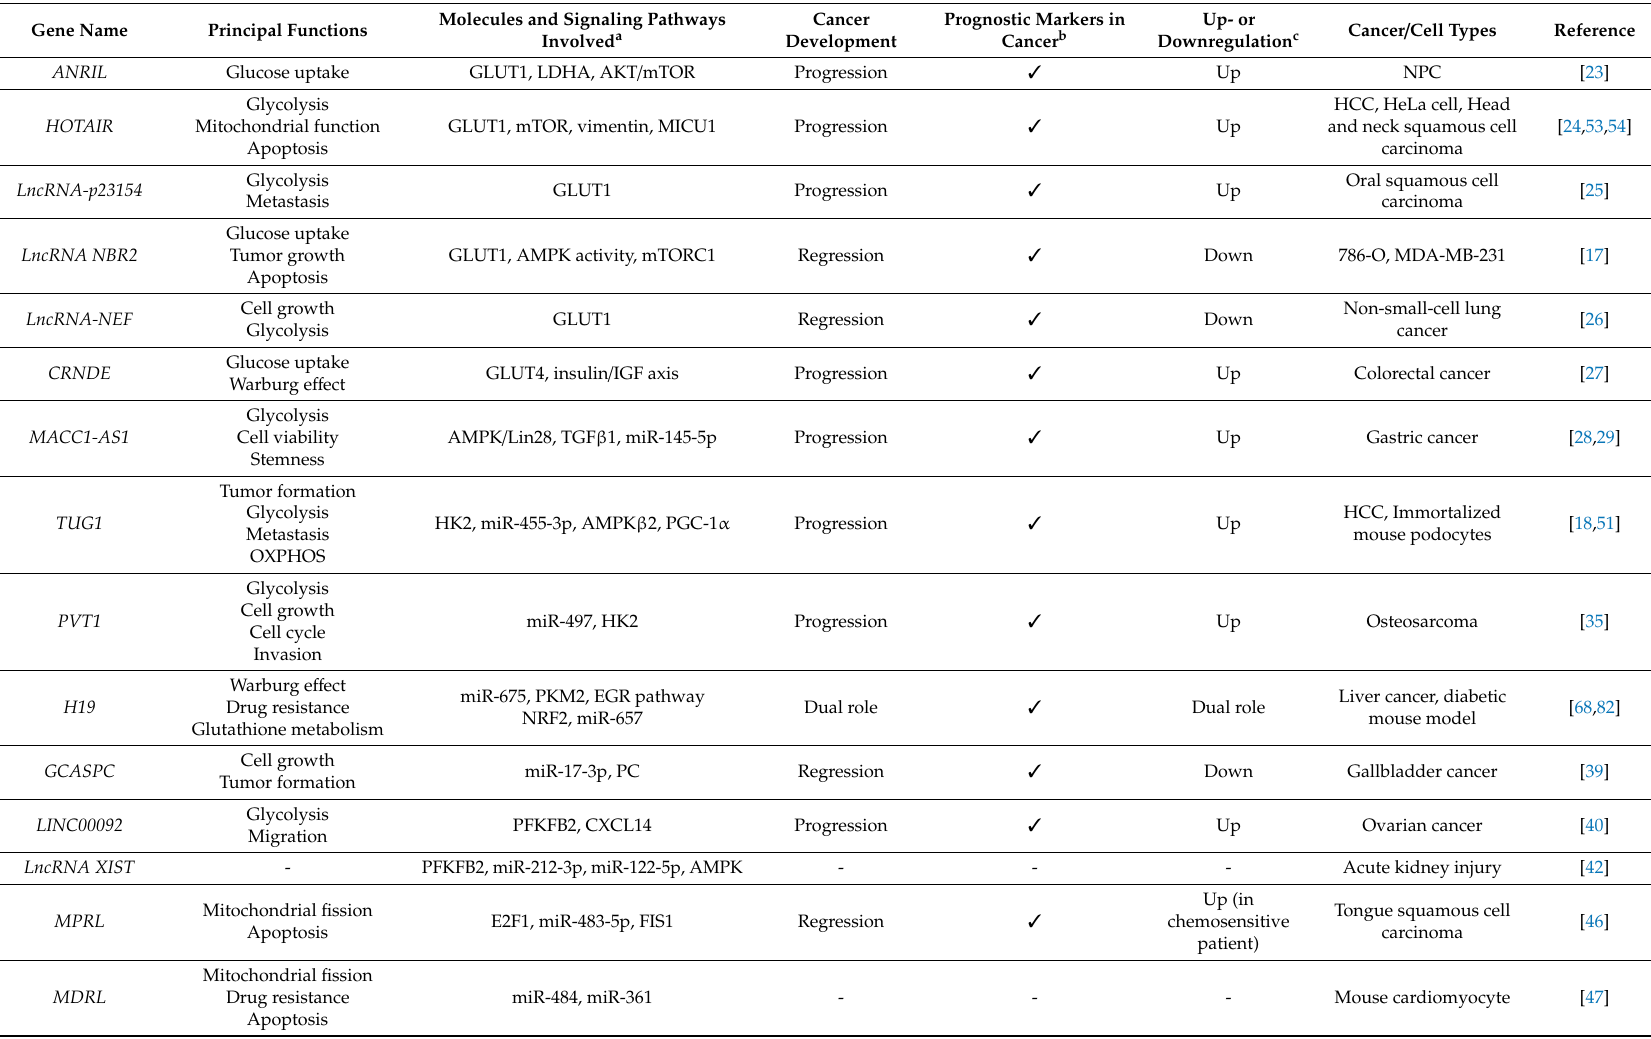
Table 1. Metabolic-regulated lncRNAs and their potential mechanisms in